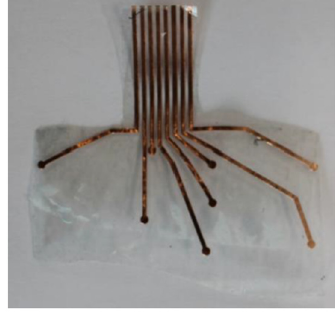
Figure 3. Sensor Route Layer.